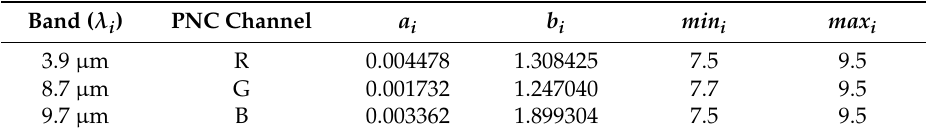
Table 1. Parameters for the linear-log transformation to the Pseudo Night